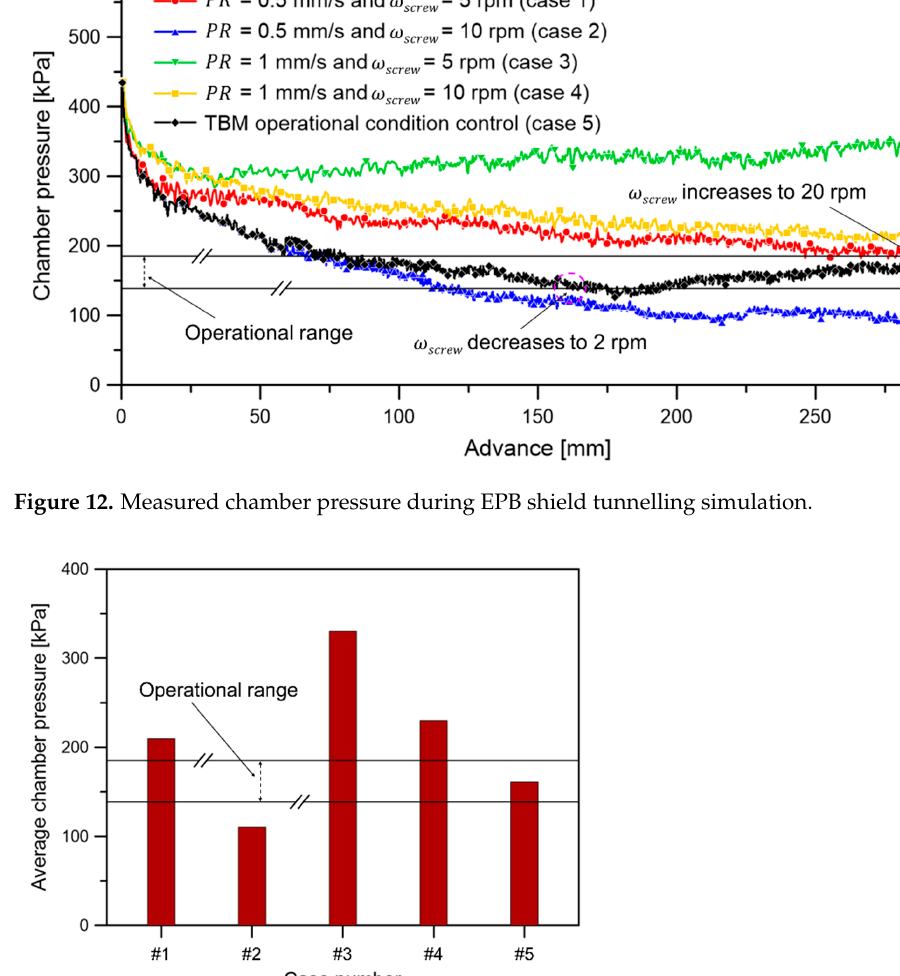
Figure 14. Measured discharged volume and discharge rate data during EPB shield tunnelling simulation.